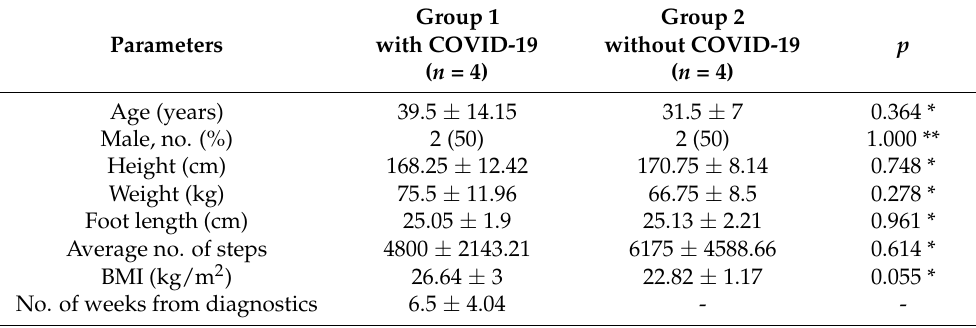
Table 1. The participant demographic and anthropometric characteristics in both groups.